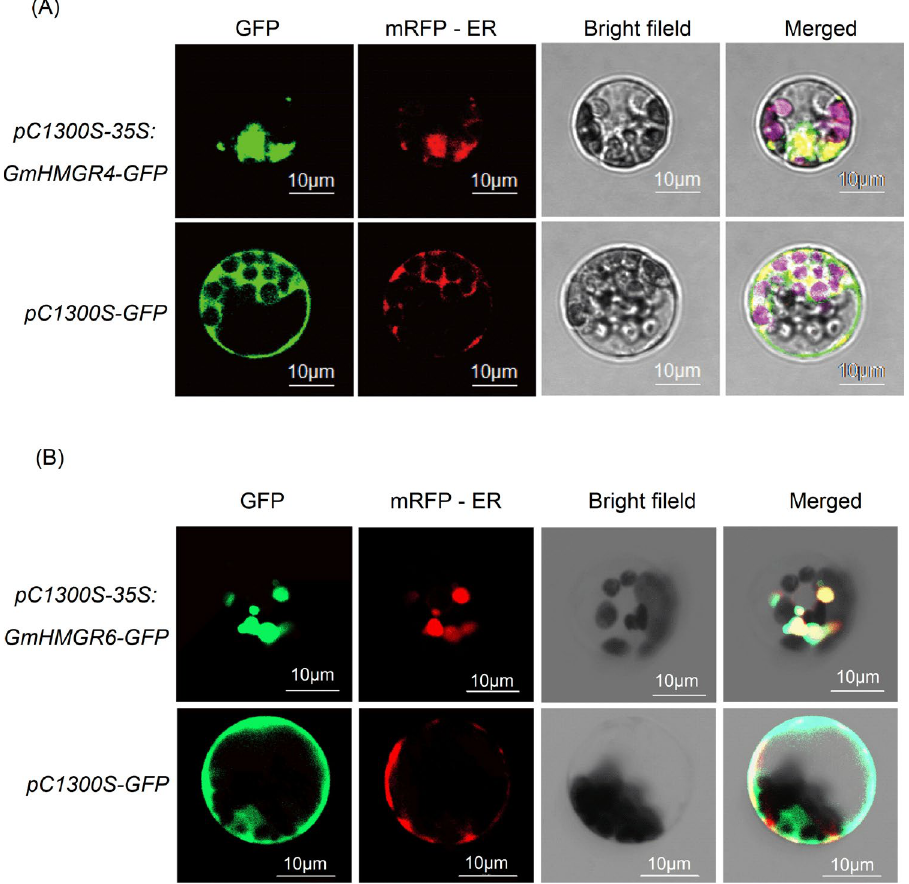
Figure 6. Subcellular localization of ( A ) GmHMGR4 and ( B ) GmHMGR6 proteins in A. thaliana protoplasts. Green fluorescence indicates a fusion protein signal for pC1300S-35S:GmHMGR4-GFP and pC1300S- 35S:GmHMGR6-GFP . The red signal indicates mRFP-ER (Endoplasmic reticulum protein marker fused with mRFP) fluorescence. GFP and mRFP-ER fluorescence images were digitally combined to get the merged